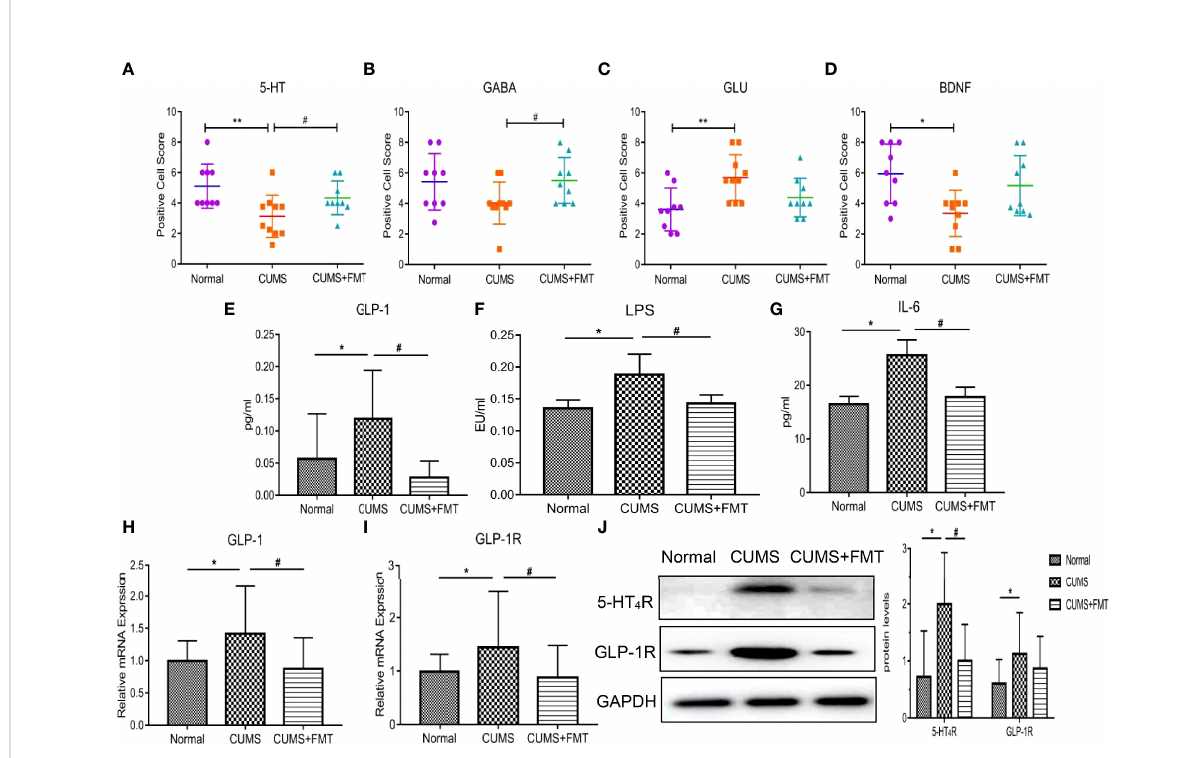
FIGURE 3 Changes in biochemical indices of each group. (A – D) , Expression of 5-HT, GABA, Glu, and BDNF in hippocampal tissues from each group; (E – G) , Expression of serum GLP-1, LPS, and IL-6 levels in each group; (H – I) , Expression of GLP-1 and GLP-1R in colonic tissue; (J) , Expression of 5-HT 4 R and GLP-1R. * p < 0.05, ** p < 0.01 compared to the control group; # p < 0.05 compared to the CUMS group. 5-HT, 5-hydroxytryptamine; 5-HT 4 R, 5-hydroxytryptamine 4-receptor; GABA, gamma-aminobutyric acid; Glu, glutamate; BDNF, brain derived neurotrophic factor; GLP-1, glucagon-like peptide-1; GLP-1R, glucagon-like peptide-1 receptor; LPS, lipopolysaccharide; IL-6, interleukin-6; CUMS, chronic unpredictable mild stress; FMT, fecal microbiota